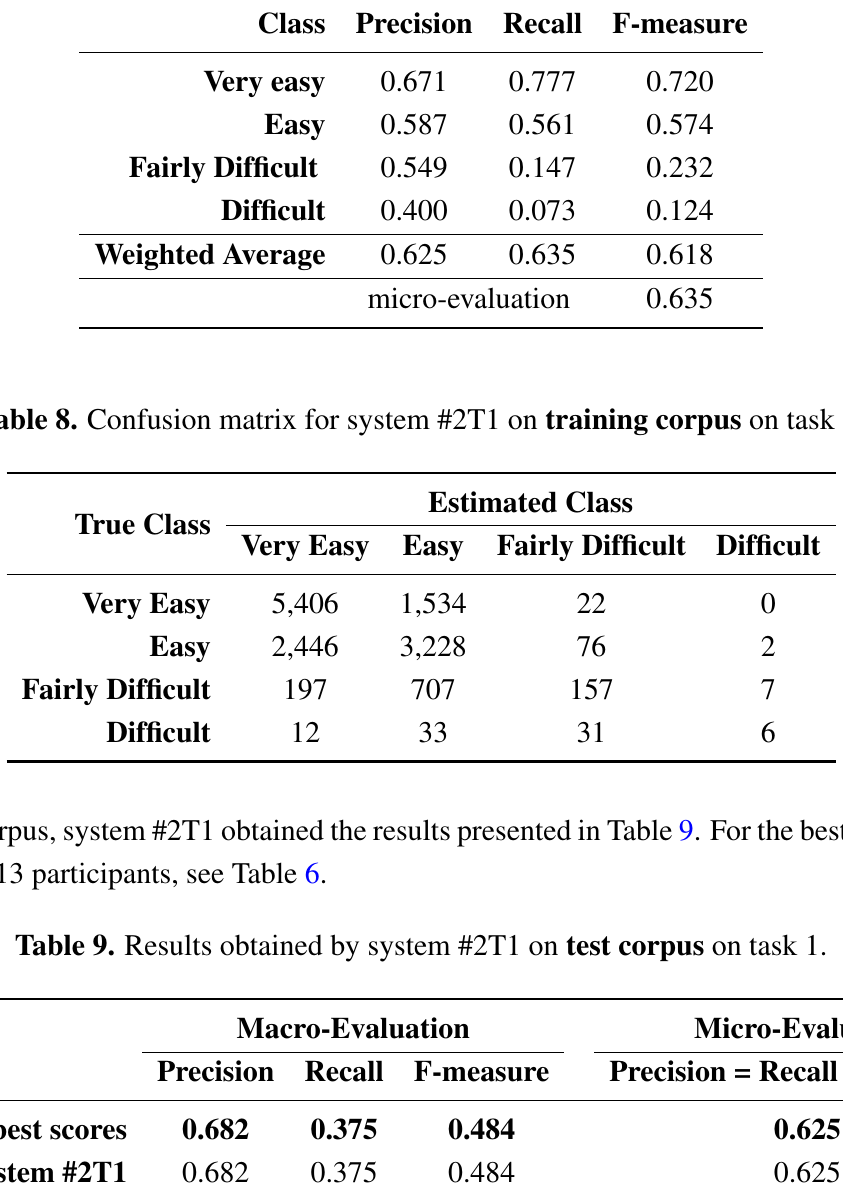
Table 7. Results obtained by system #2T1 on training corpus on task 1.